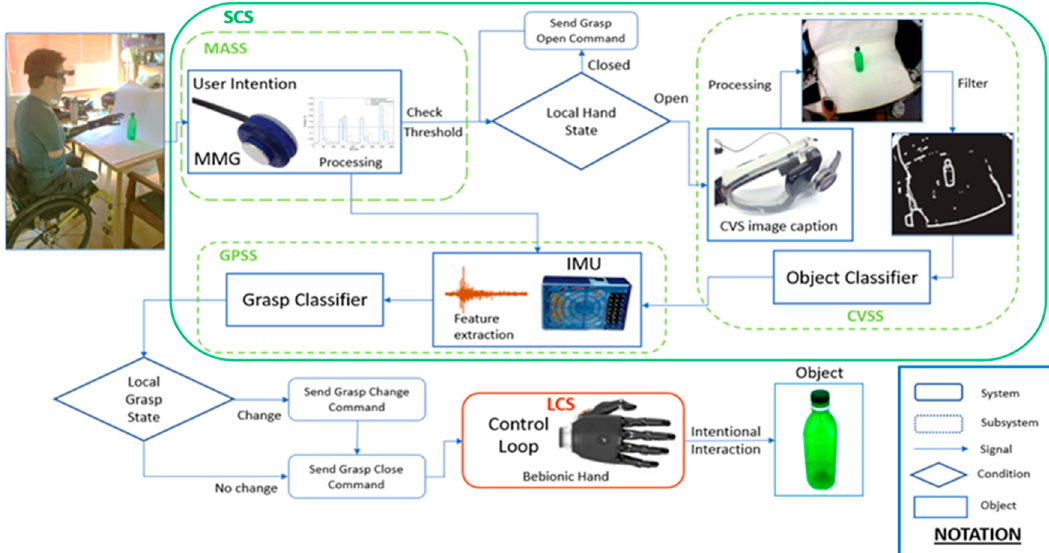
Figure 1. System overview of the heterogeneous sensor suite. The control architecture can be separated into a local control system (LCS) and a sensor control system (SCS). The muscle activation subsystem uses a mechanomyography (MMG) sensor to monitor the operator’s muscle response against an activation threshold. The pipeline consists of the computer vision subsystem (CVSS) and the grasp prediction subsystem (GPSS). The output of the SCS is sent to the LCS, where it is translated into motor commands to engage in intentional interaction.